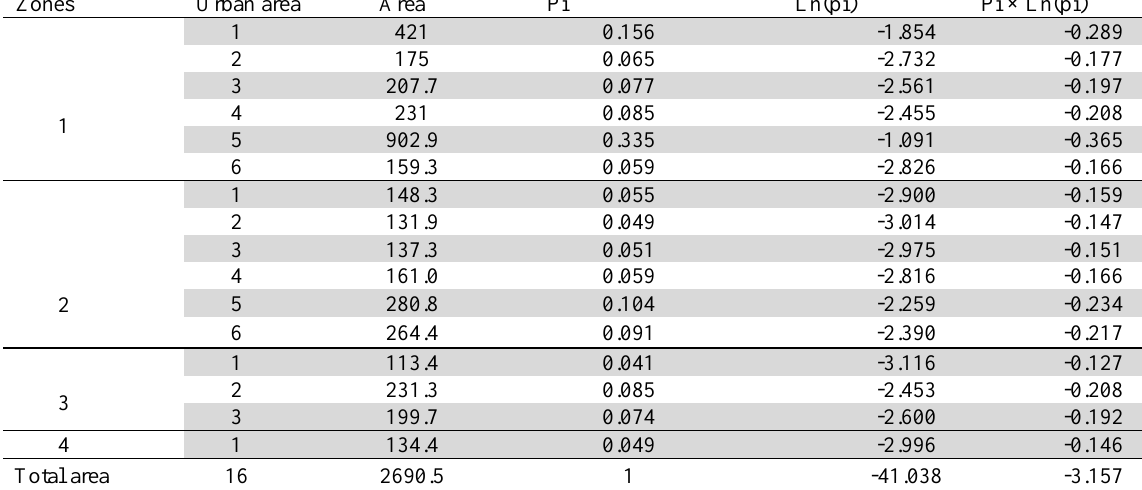
Calculation of the Shannon entropy for the year 1379(2000) in Sari